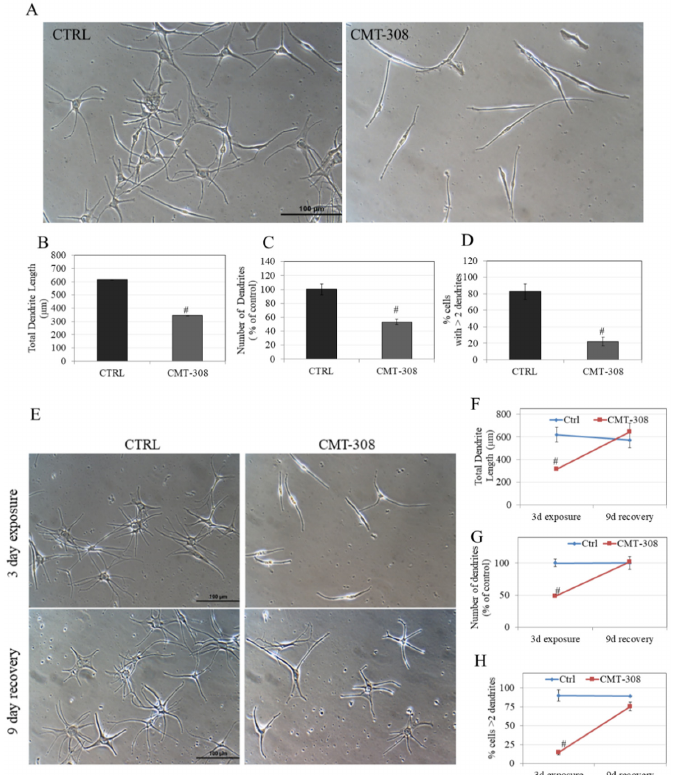
Figure 7. ( A ) Representative phase-contrast micrographs of HEMn-DP cells of Ctrl (0.4% DMSO) and CMT-308 (10 µM)-treated groups; quantification of melanocyte dendricity by ( B ) total dendrite length; ( C ) number of dendrites; ( D ) % cells with >2 dendrites; # p < 0.01 vs. Ctrl; ( E ) representative phase-contrast micrographs of HEMn-DP cells showing exposure and recovery of Ctrl and CMT-308-treated groups; quantification of dendricity by ( F ) total dendrite length; ( G ) number of dendrites; and ( H ) % cells with > 2 dendrites; # p < 0.01 vs. Ctrl; data is mean ± SD of one representative experiment in triplicates with a total of 50–60 cells counted per